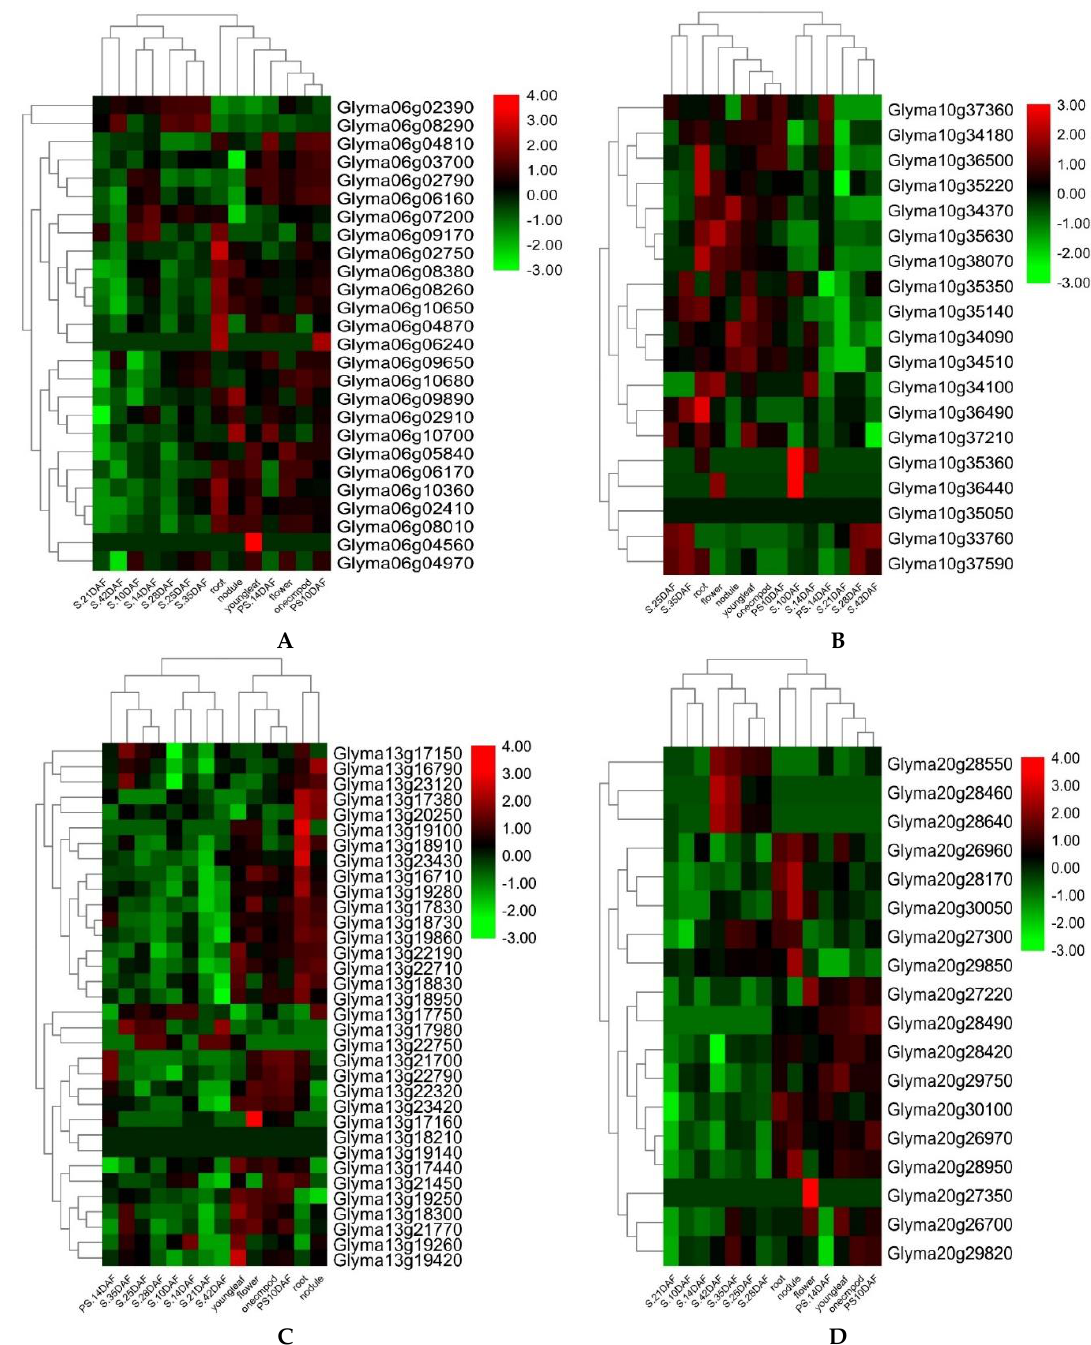
Figure 5. Heat map exhibiting the expression profiles of 23 candidate genes among the different soybean tissues and development stages from four QTL hotspots/clusters. (A) Cluster-06 (QTL Hotspot A), (B) Cluster-10 (QTL Hotspot B), (C) Cluster-13 (QTL Hotspot C), and (D) Cluster-20 (QTL Hotspot D). Heat map was generated using the RNA-sequencing data downloaded from online dataset SoyBase. Youngleaf—young leaf, Onecmpod—1 cm of pod, PS—pod shell, DAF—days after flowering, and S—seed. Table 6. Predictive gene annotation information.